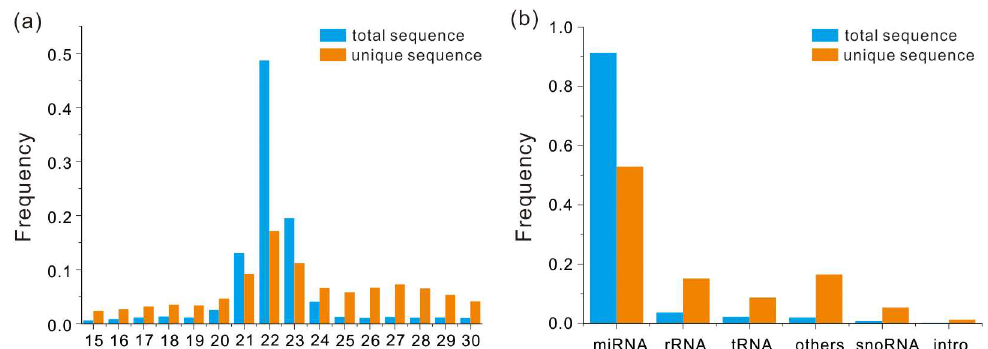
Fig 2. Comparison of total and unique sequence in G . przewalskii . (a) Size distribution and frequency of miRNAs in both types of sequences.The 22-nt-length of small RNA is abundantin both types. (b) Frequency of total and uniquesequencesof putative RNAs, includingmiRNA, tRNA, tRNA, rRNA, snoRNA and intro. The most abundantof RNAs are miRNA in both types of sequences. The total and uniquesequenceswere coloredby blue and orange,